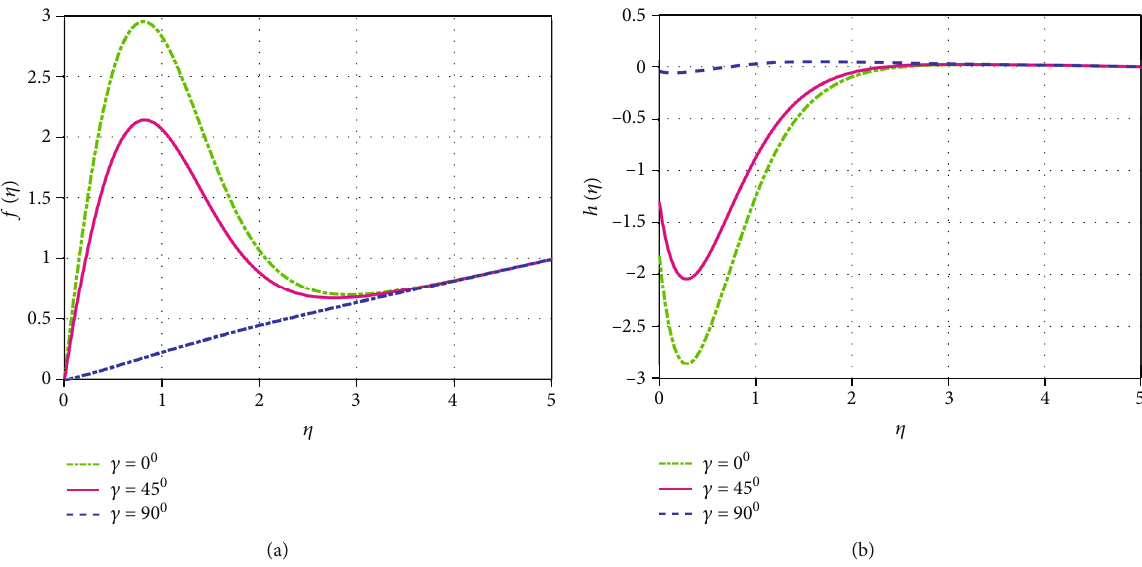
Figure 10: (a) Velocity, and (b) micro-rotation pro fi les for inclined angle variation with M =2, c =0.5, R =0.5, Pr =0.71, Sc =0.22, L λ = 1, ξ =3, K =0.5, Gr =10, and Gc 1